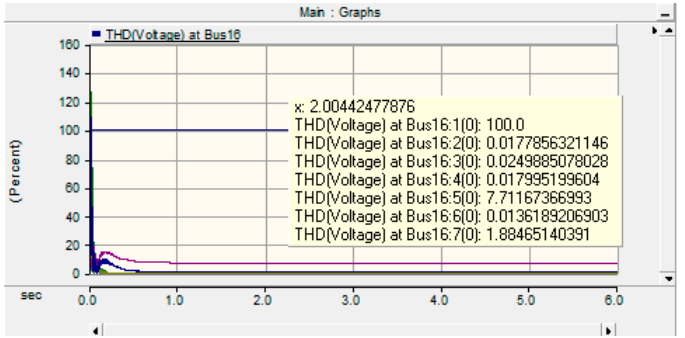
Figure 8. The harmonic components at the point of common coupling of the priority customer